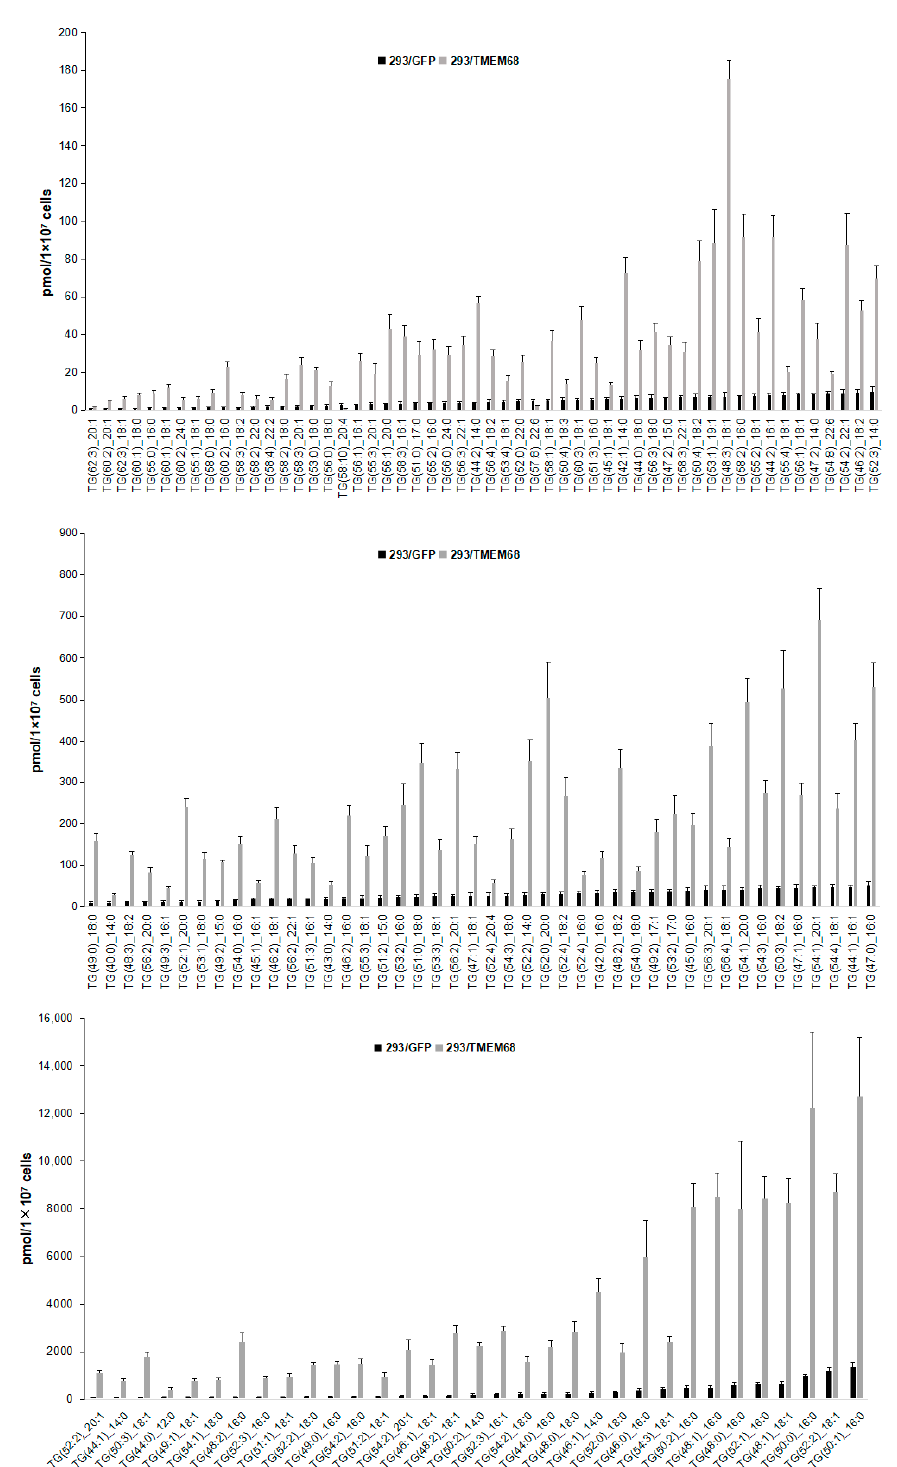
Figure 6. Comparing the levels of differentiated TG species between 293/GFP and 293/TMEM68 cells. TG levels were quantified by MetWare based on the AB Sciex QTRAP 6500 LC-MS/MS platform and the differentiated TGs were screened by VIP ≥ 1, FC ≥ 2.0 or FC ≤ 0.50. Data were presented as means ± SD. All p < 0.01, n = 6.